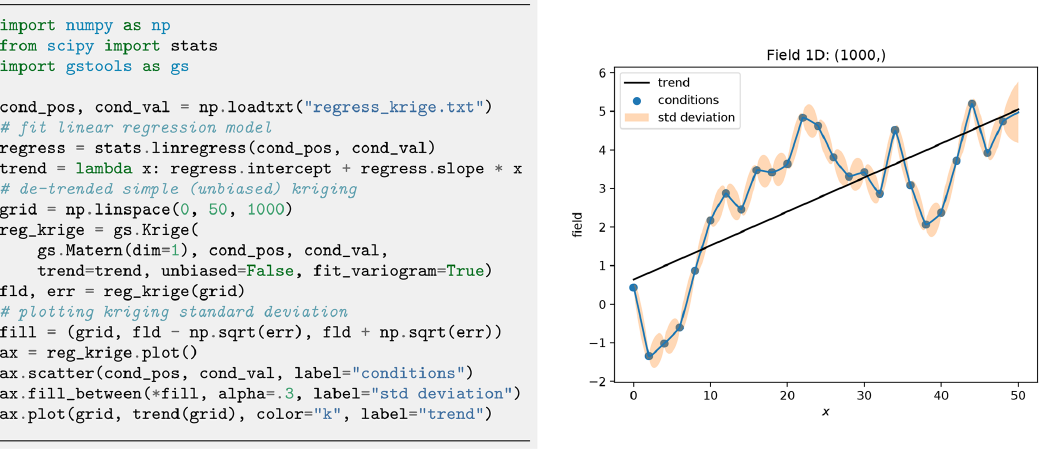
Figure 10. A simple setup for linear regression kriging. Although the interpolation coincides with a piecewise linear function, we gain information about the error variances between the conditioning points as shown in the right